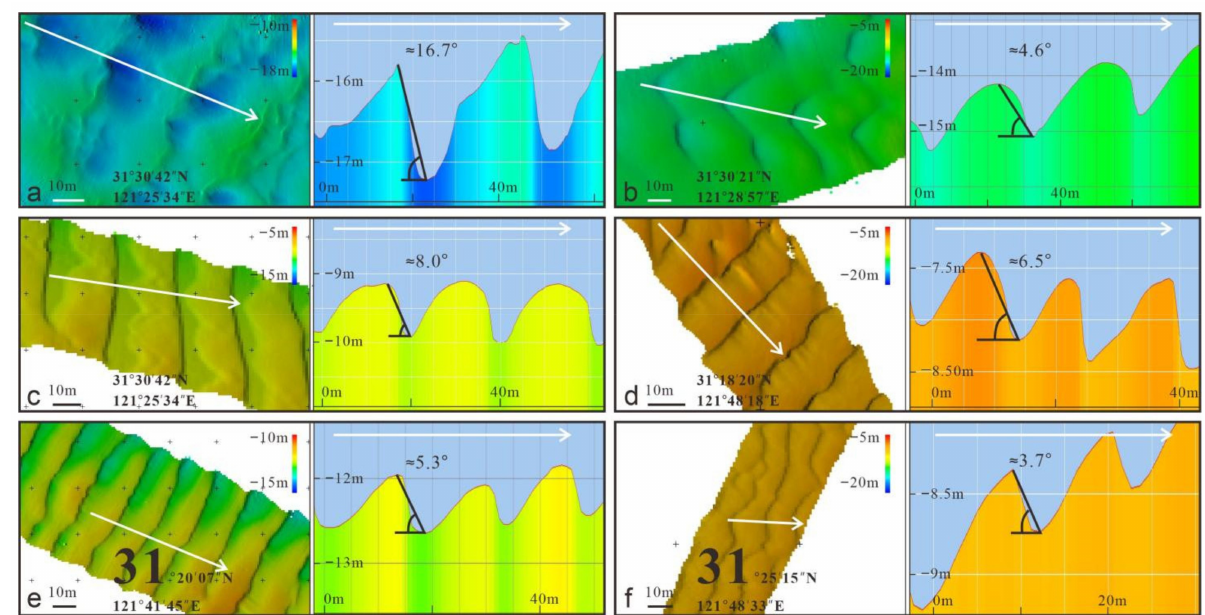
Figure 7. Dune parameters and lee-side slope angle of dunes in the YR Estuary. ( a ) catenary-bead dunes with lee-side angle of ~16.7 ◦ ; ( b , d ) are curved dunes with lee-side angle of ~4.6–6.5 ◦ ; ( c , e ) are liner dunes with lee-side angle of 5.3–8 ◦ ; ( f ) the catenary dunes with angle of − 3.7 ◦